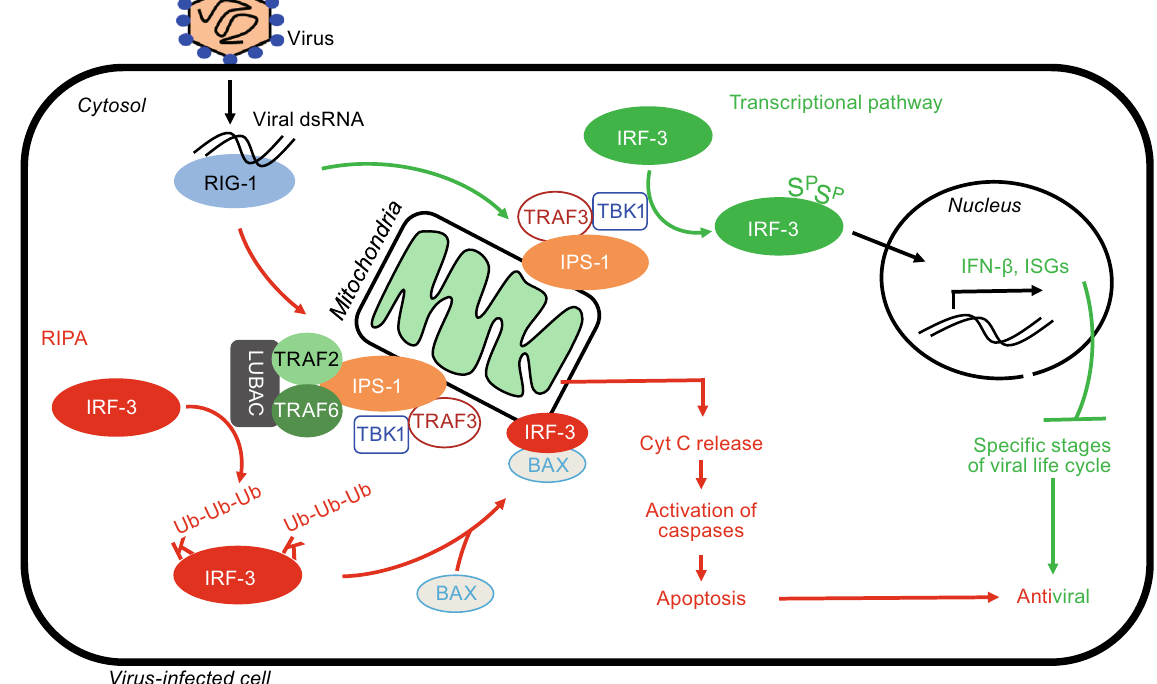
Figure 1. DualfunctionsofIRF3inantiviraldefense. VirusinfectionisrecognizedbythecytoplasmicsensorRIG-I,whichbindstoviral double-stranded RNA and triggers two signaling branches via mitochondrial adaptor IPS1. In the transcriptional pathway, IRF3 is translocatedtothenucleustoinduceantiviralgenes,suchastheinterferon-beta(IFN- β )andinterferonstimulatedgenes(ISGs).Incontrast, in the RIPA branch, IRF3 is activated by LUBAC-mediated linear ubiquitination, which triggers its interaction with BAX to cause mitochondrial activation and apoptotic cell death. Both pathways contribute to the overall antiviral responses of the